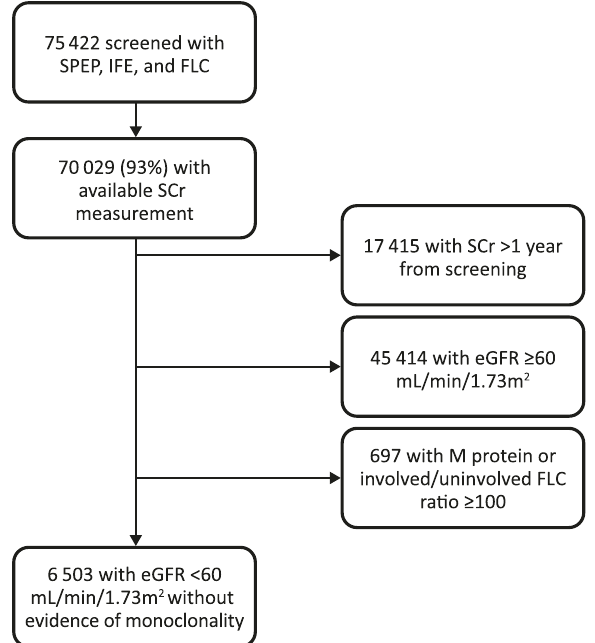
Fig. 1 Flowchart outlining the study population and excluded participants. SPEP Serum protein electrophoresis, IFE Immuno fi xa- tion, FLC Free light chains, SCr Serum creatinine, eGFR Estimated glomerular fi ltration